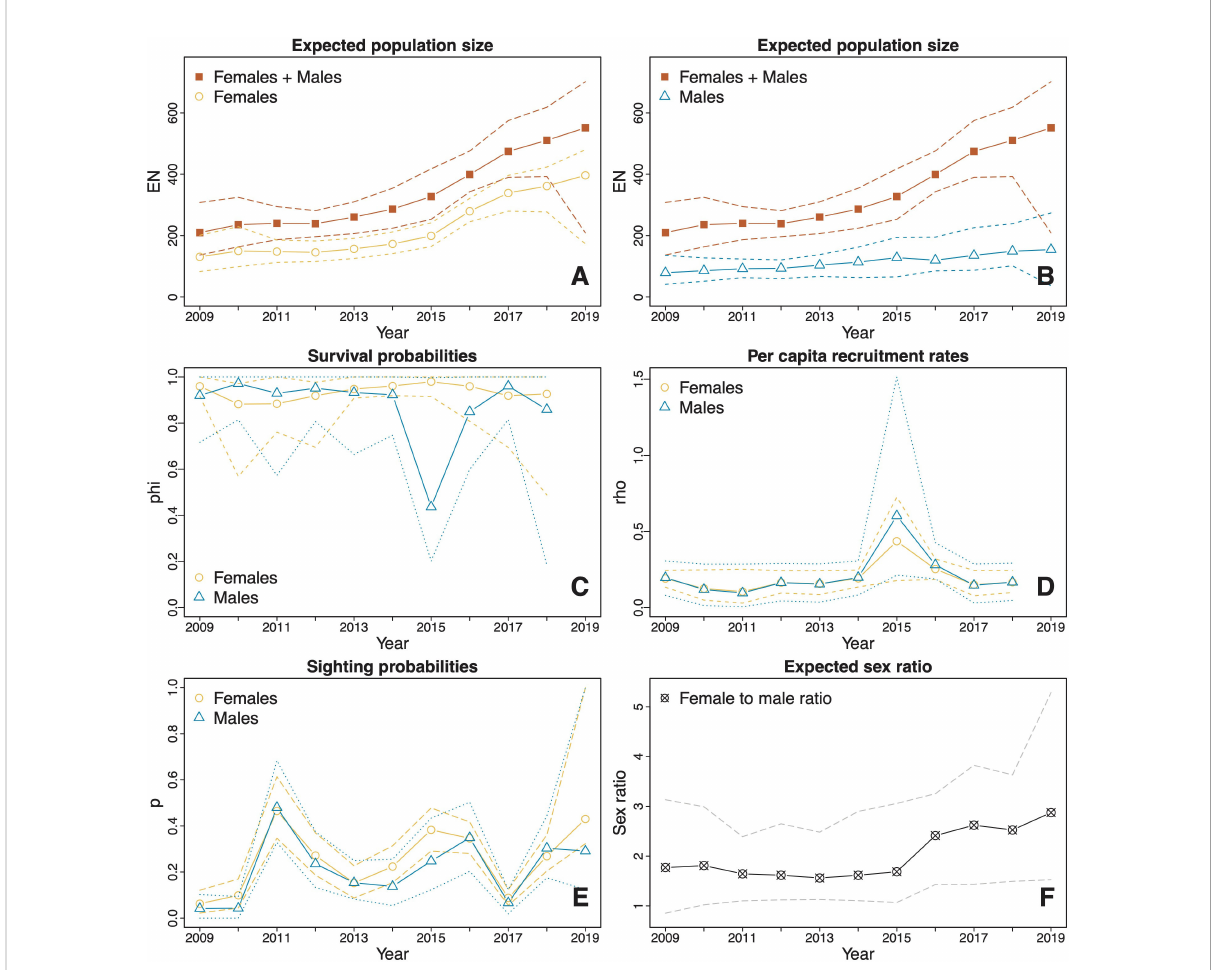
FIGURE 4 Estimates (solid lines) and CIs (dotted and dashed lines) derived from model averaging procedures for the M. alfredi subpopulation in the SE Misool MPA. (A, B) The estimated expected population sizes of females and males relative to the estimated expected overall population sizes of both sexes combined; (C) Survival probabilities of females and males; (D) Per capita recruitment rates of males and females; (E) Sighting probabilities of females and males; and (F) Expected female to male ratio. The orange lines represent female estimates, blue lines represent male estimates, and red lines represent total estimates of females and males. Black and grey lines represent sex ratio estimates (female to male). Dotted lines represent upper and lower con fi dence